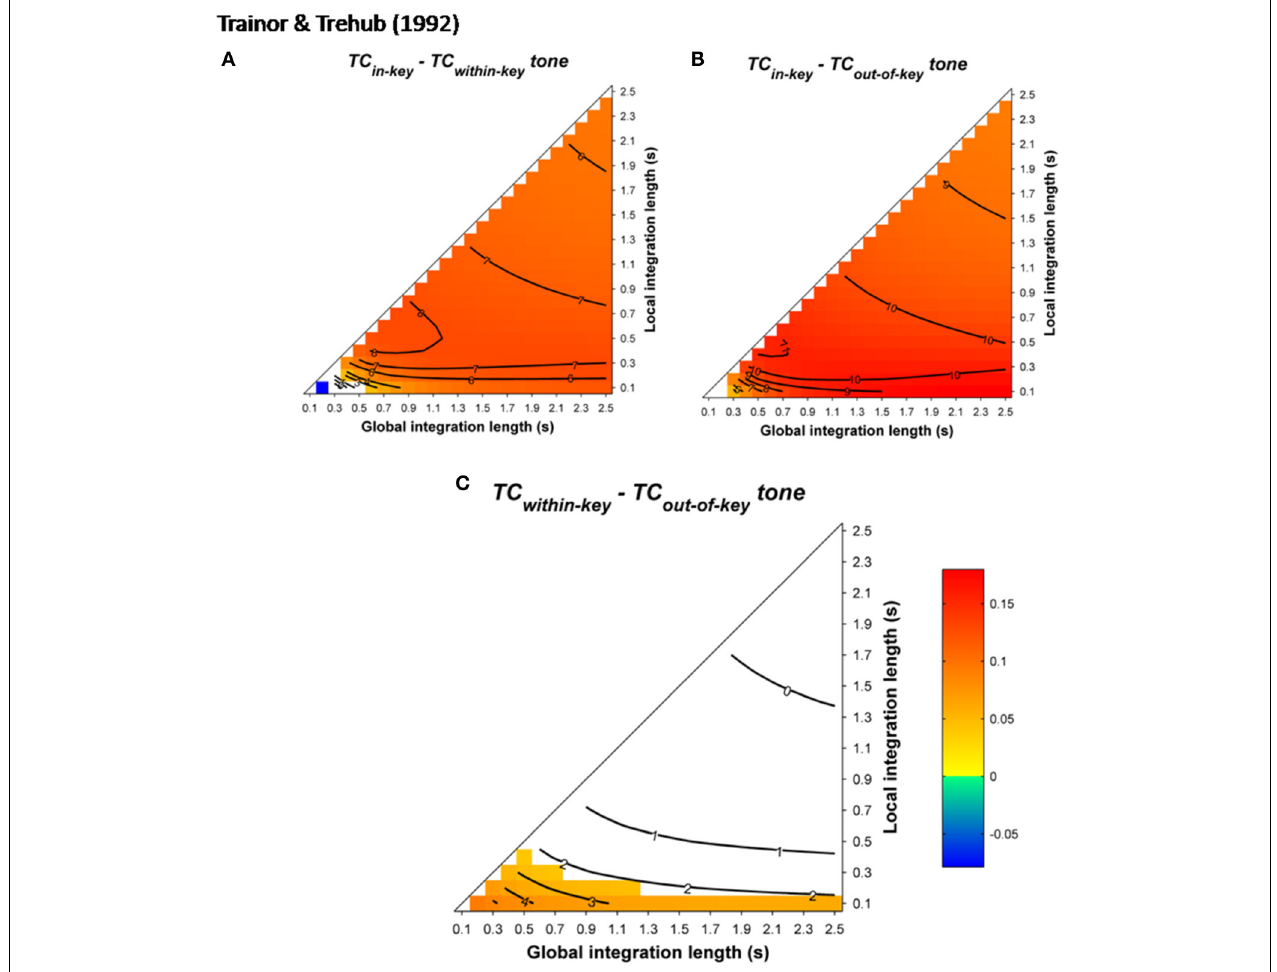
FIGURE 15 | Simulation of Trainor and Trehub’s (1992) study. Panels (A,B) show the TC differences for in-key minus within-key and in-key minus out-of-key targets, respectively. Positive, negative, and nonsignificant differences are represented by hot, cold, and white colors, respectively (two-tailed paired t -test, p < 0 . 05; t -values are reported as contours). All differences are positive (red) for both targets, but out-of-key targets are less